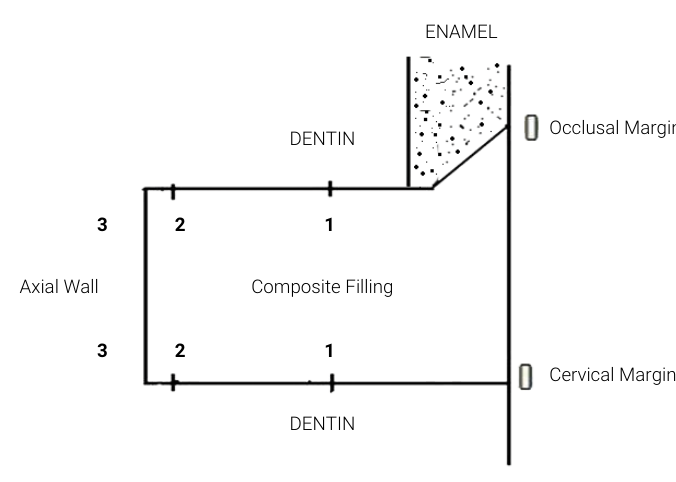
Figure 2. Schematic figure of dye penetration in specimens.